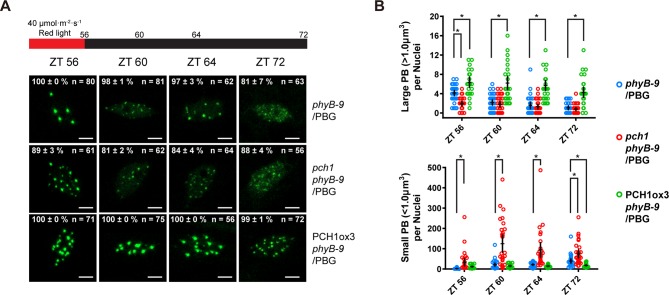
Fewer large photobodies were detected in pch1 with higher intensity of red light treatment.(A) Representative confocal images showing phyB-containing photobodies in phyB-9, pch1 phyB-9 and PCH1ox3 phyB-9 plants expressing a phyB-GFP (PBG) fusion protein. Plants were entrained by the short day condition supplemented with 40 µmol·m-2·s-1 of red light for two days before extended dark treatment. Scale bars indicate 5 µm. The percentage value in each representative image indicates the mean percentage of all nuclei with the phenotypes shown in the image (with or without photobodies) from three independent experiments. n indicates the total number of nuclei to generate the percentage. (B) Quantitative measurements of photobodies larger than 1.0 μm3 (Large PB, upper) or smaller than 1.0 μm3 (Small PB, lower) were analyzed in all seedlings and indicated by Mean ± 95% CI (n ≥ 29). * symbol indicates significantly different (p<0.05, see text for more details about each p value).